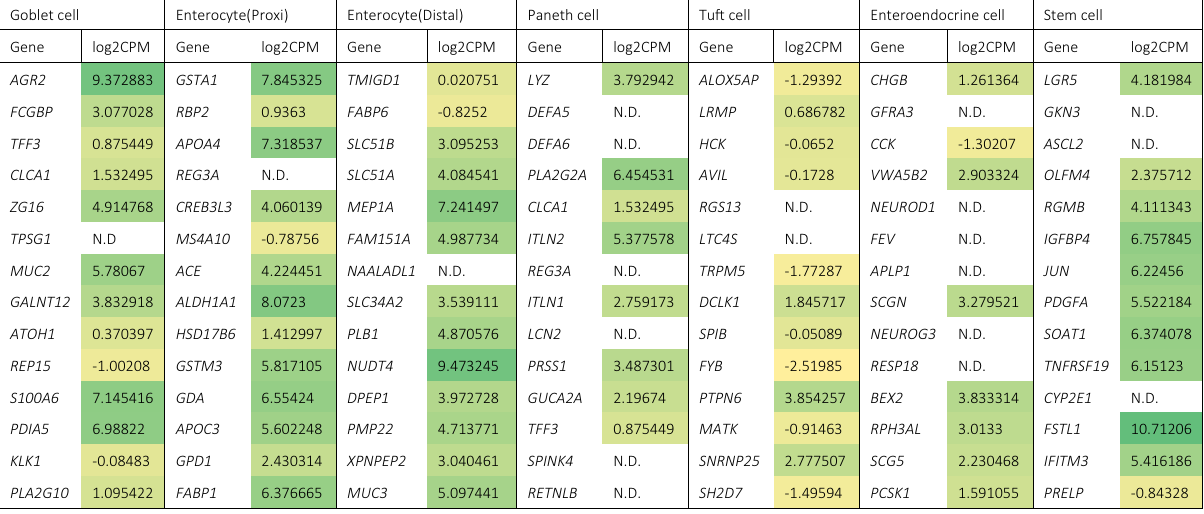
Table 1. Gene expression in log2 values (counts per million) of selected marker genes for specific intestinal cell types in induced pluripotent stem cell derived intestinal epithelial cell layer control samples. N.D.: not detectable. Colours were scaled from low expression (yellow) to high expression (green). Data are expressed as averages of 3